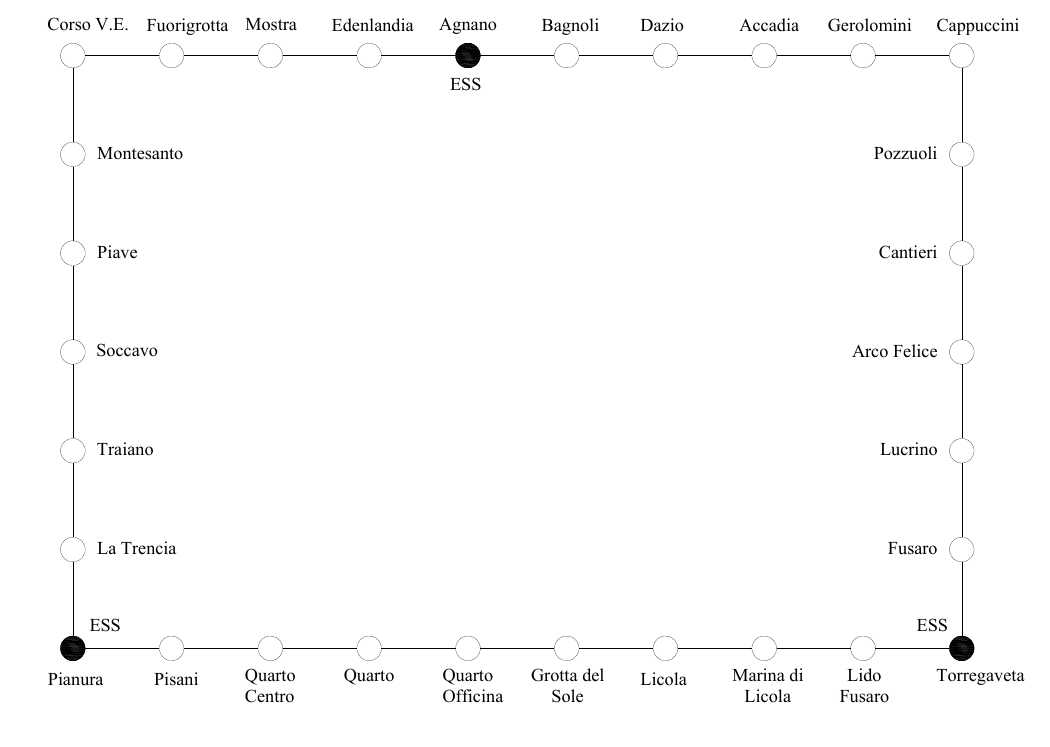
Table 1. Characteristics of the Agnano-Torregaveta